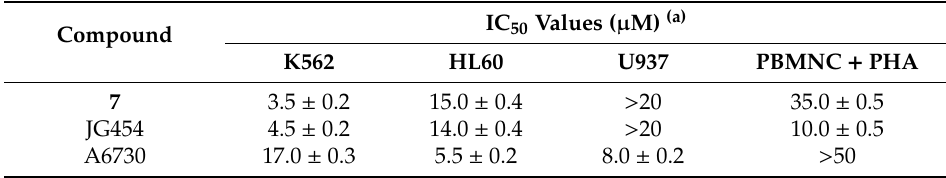
Table 1. In vitro activity of compounds 7 , JG454 and A6730 on K562, HL60, and U937 cells, and cytotoxicity on human peripheral blood mononuclear cells PBMNC +